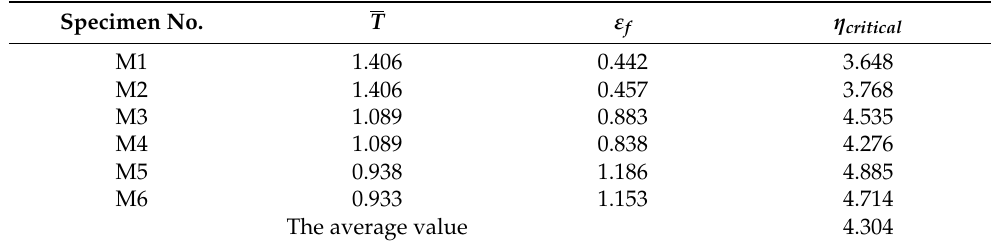
Table 3. Calibration of η critical in VGM. Specimen No.